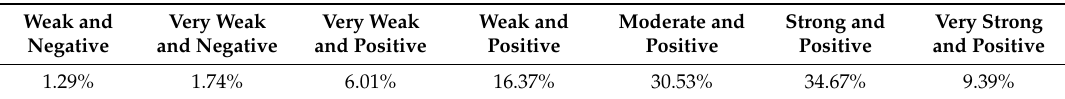
Table 1. The proportions of the CHP with different correlation strengths.